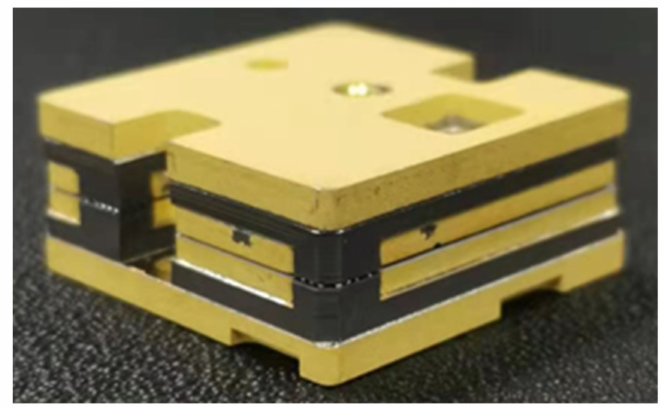
Figure 13. T/R module